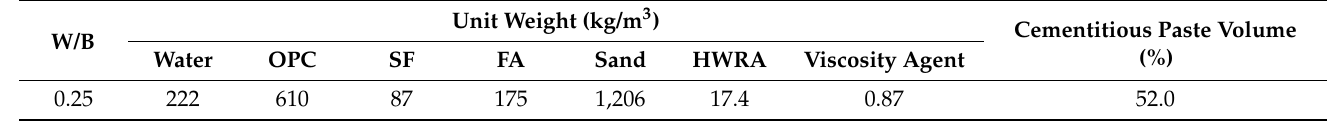
Table 1. Physical properties of the aggregates